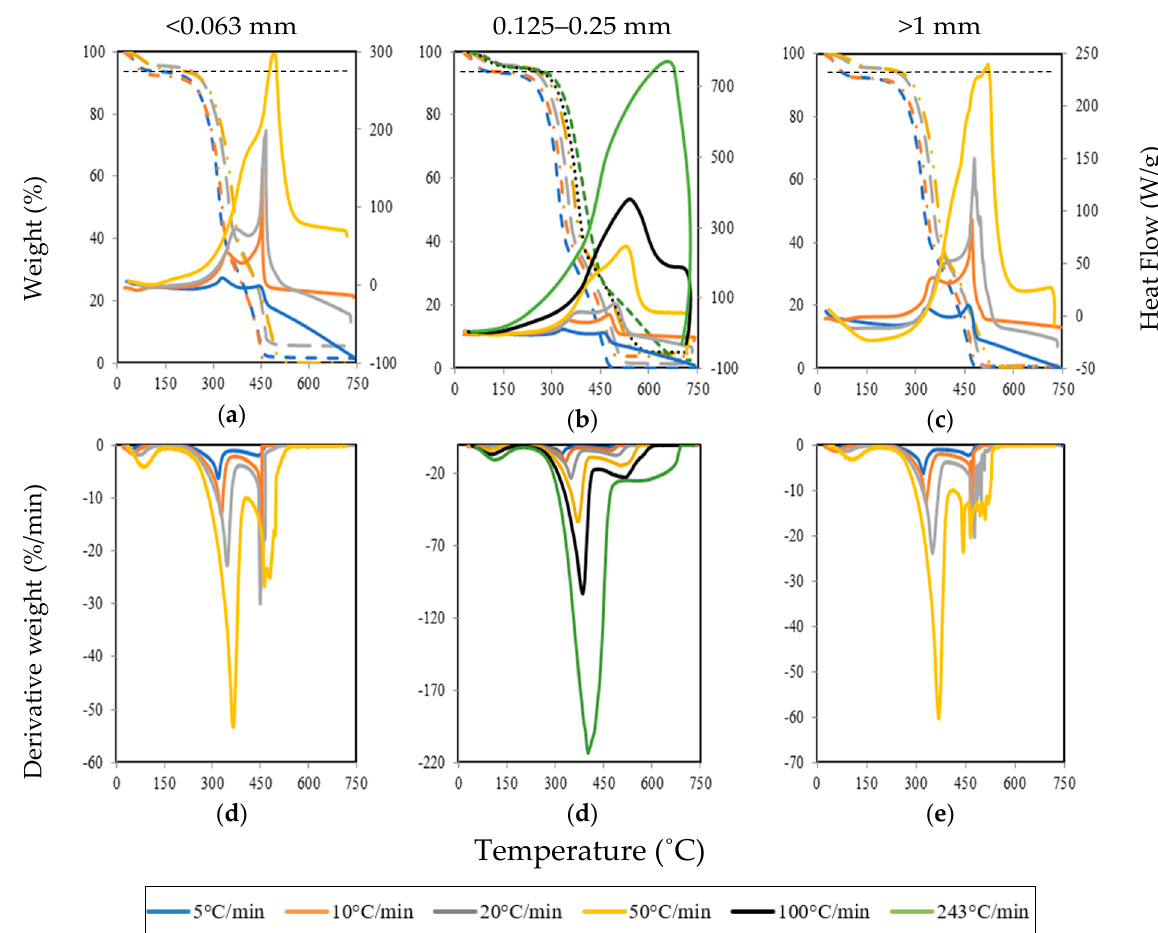
Figure 3. Thermogravimetric (TG) and heat flow (( a ), ( b ), and ( c )) and DTG (( d ), ( e ), and ( f )) profiles for the different particle sizes under different heating rates. Table 2. Characteristic temperatures and burnout time for all particle sizes under different heating rates.